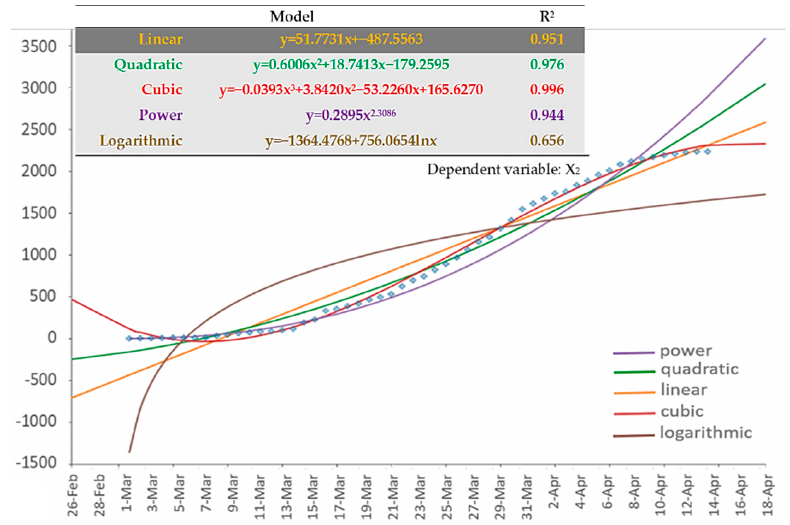
Figure 6. Available types of fitting curves applied to the cumulative COVID-19 infection curve (variable X 2 ) of Greece. Time-series data of the variable are shown in dots.